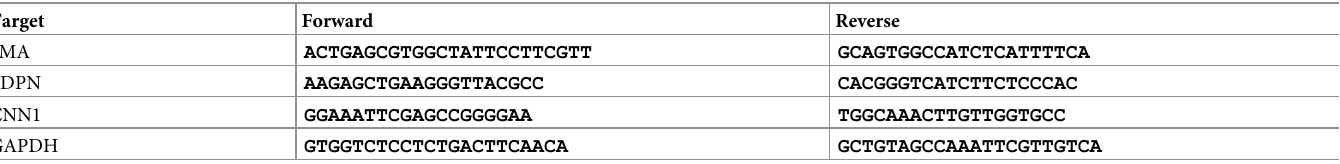
Table 1. Primers used for real-time